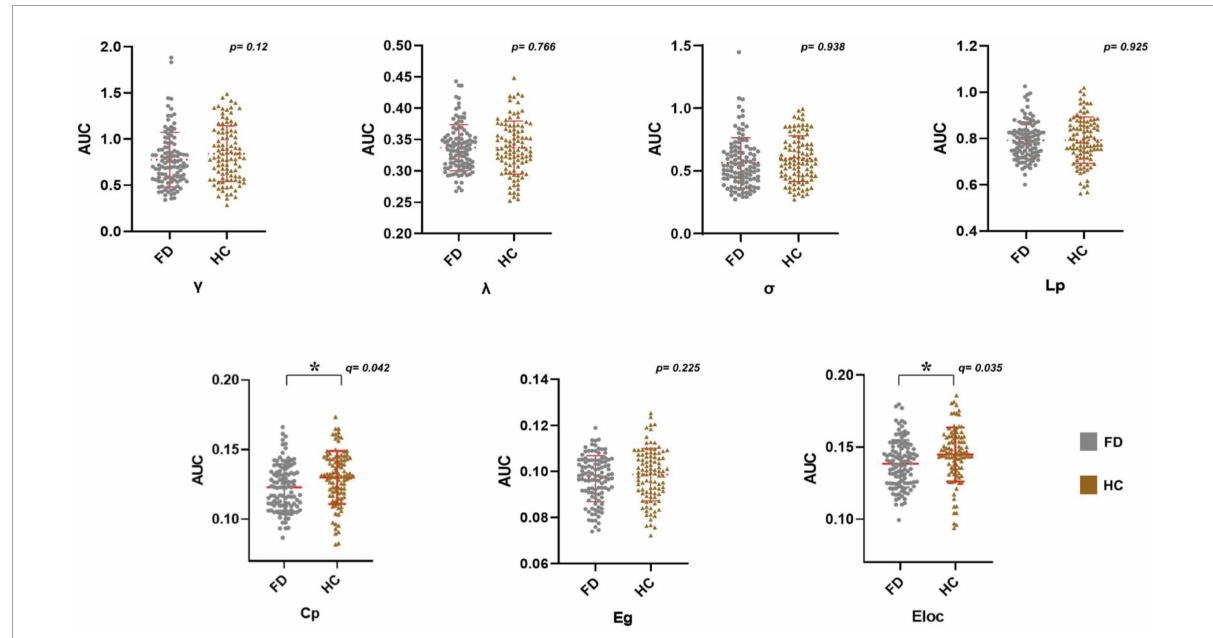
FIGURE2 Alterations in the AUC of global network metrics in FD patients. FD patients showed a significantly lower Cp and Eloc (* p FDR < 0.05). Abbreviations: AUC, area under the curve; FD, functional dyspepsia; HC, health controls; γ , normalized clustering coefficient; λ , normalized characteristic path length; σ , small worldness; Cp, clustering coefficient; Lp, characteristic path length; Eglob, global efficiency; Eloc, local efficiency; FDR, false discovery rate.